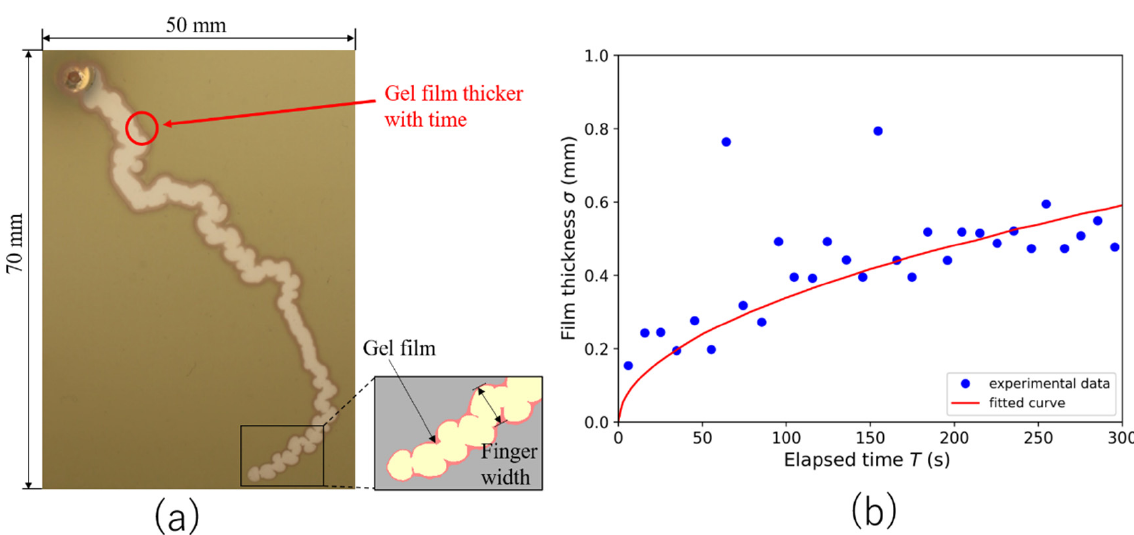
Figure 2. ( a ) A typical finger structure consists of bubble-like patterns with gel formation (red) generated at a 15 wt% concentration of the citric acid, an injection rate Q of 1.0 mL/h, and a gap width b of 0.4 mm. The skim milk was doped with a methyl red pH indicator. ( b ) The sequential thickening of the gel film at the interface of the skim milk and aqueous citric acid solution. The blue dot represents the experimental result, whereas the red line is the fitting curve based on Equation (1).